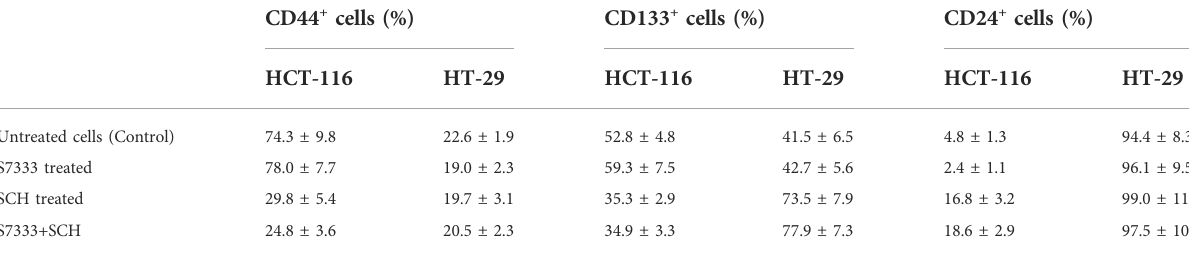
TABLE 2 Comparison of positive cells (%) of cancer stem surface makers between HCT-116 and HT-29 cells after S7333 or SCH or combined